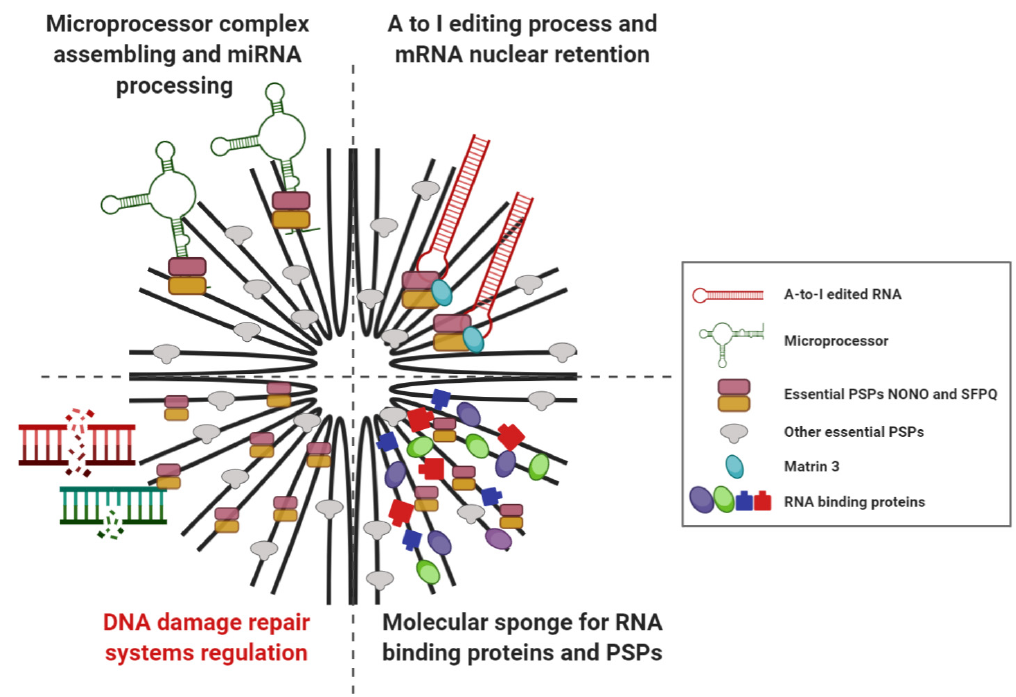
Figure 3. Graphical summary of PSs cellular functions. Upper, right panel: PSs as a gene expression regulator through the A to I editing process and the consequent nuclear retention of different mRNAs. Lower, right: PSs as molecular sponges for RNA binding proteins and PSPs. Upper, left: PSs as regulator of miRNA biogenesis by regulating the assembling of the microprocessor complex involved in processing of miRNA. Lower, left: PSs as possible structural scaffold for cellular DNA damage response systems.